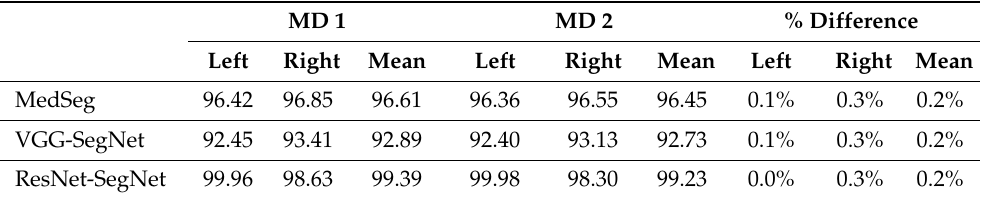
Table 1. FoM table for COVLIAS and MedSeg for lung area error against MD.